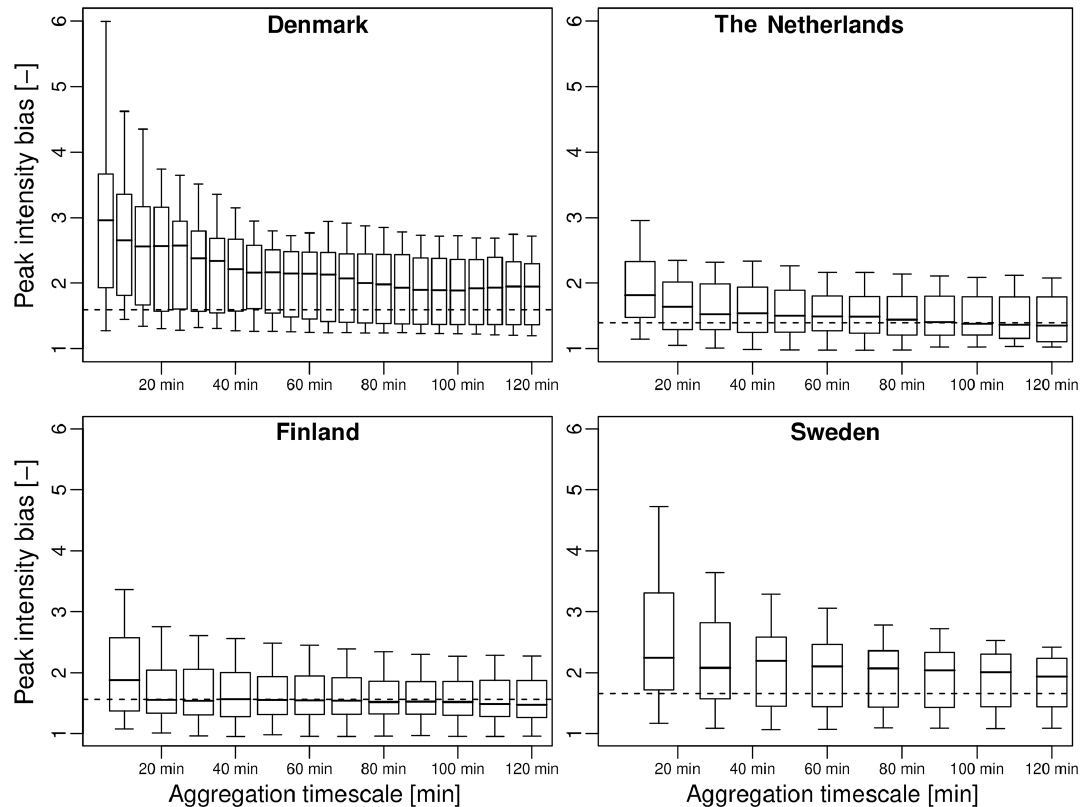
Figure 9. Boxplots of peak intensity bias versus aggregation timescale. Each boxplot represents the 10%, 25%, 50%, 75% and 90% quantiles for the 50 top events in each country. The horizontal lines denote the average multiplicative biases (G / R ratio). Table 4. Summary statistics for the highest aggregation timescale (all 50 events combined). G / R ratio and G / R ratio corrected for areal- reduction factor ARF, model bias β assuming log-normal distribution and relative increase in β with respect to intensity and range. Country G / R G / R corrected model bias relative increase in β relative increase in